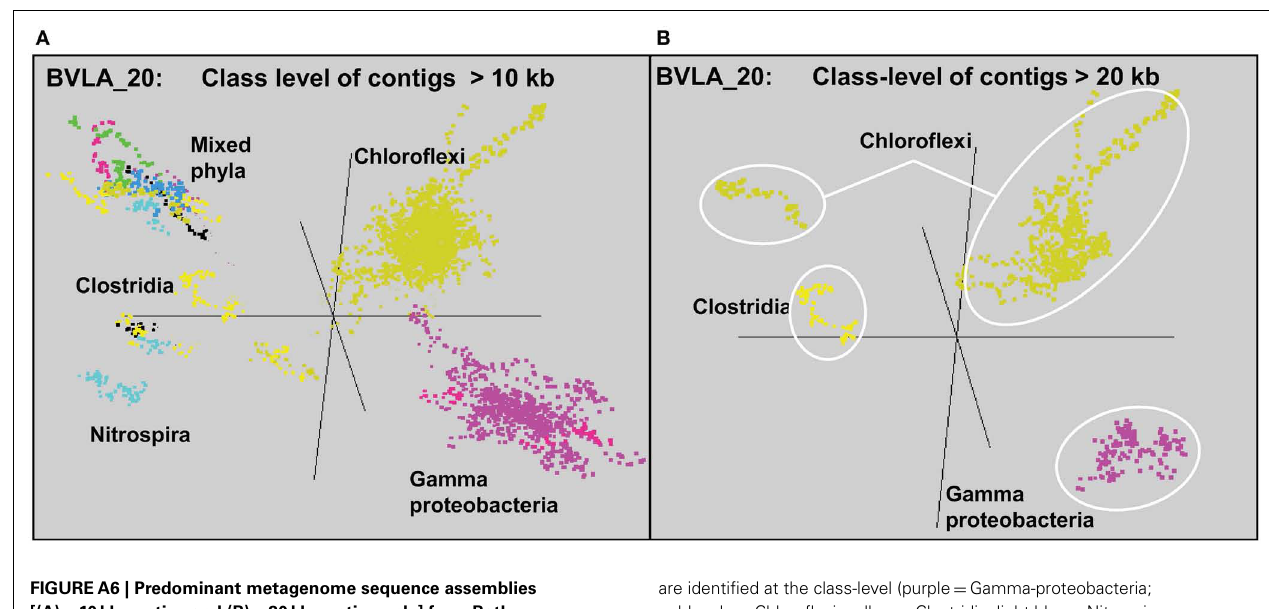
FIGUREA6 | Predominant metagenome sequence assemblies [(A) > 10kb contigs and (B) > 20kb contigs only] from Bath LakeVistaAnnex (BLVA_20) sampled during a bloom of purple-sulfur bacteria (Gamma-proteobacteria) . Major clusters